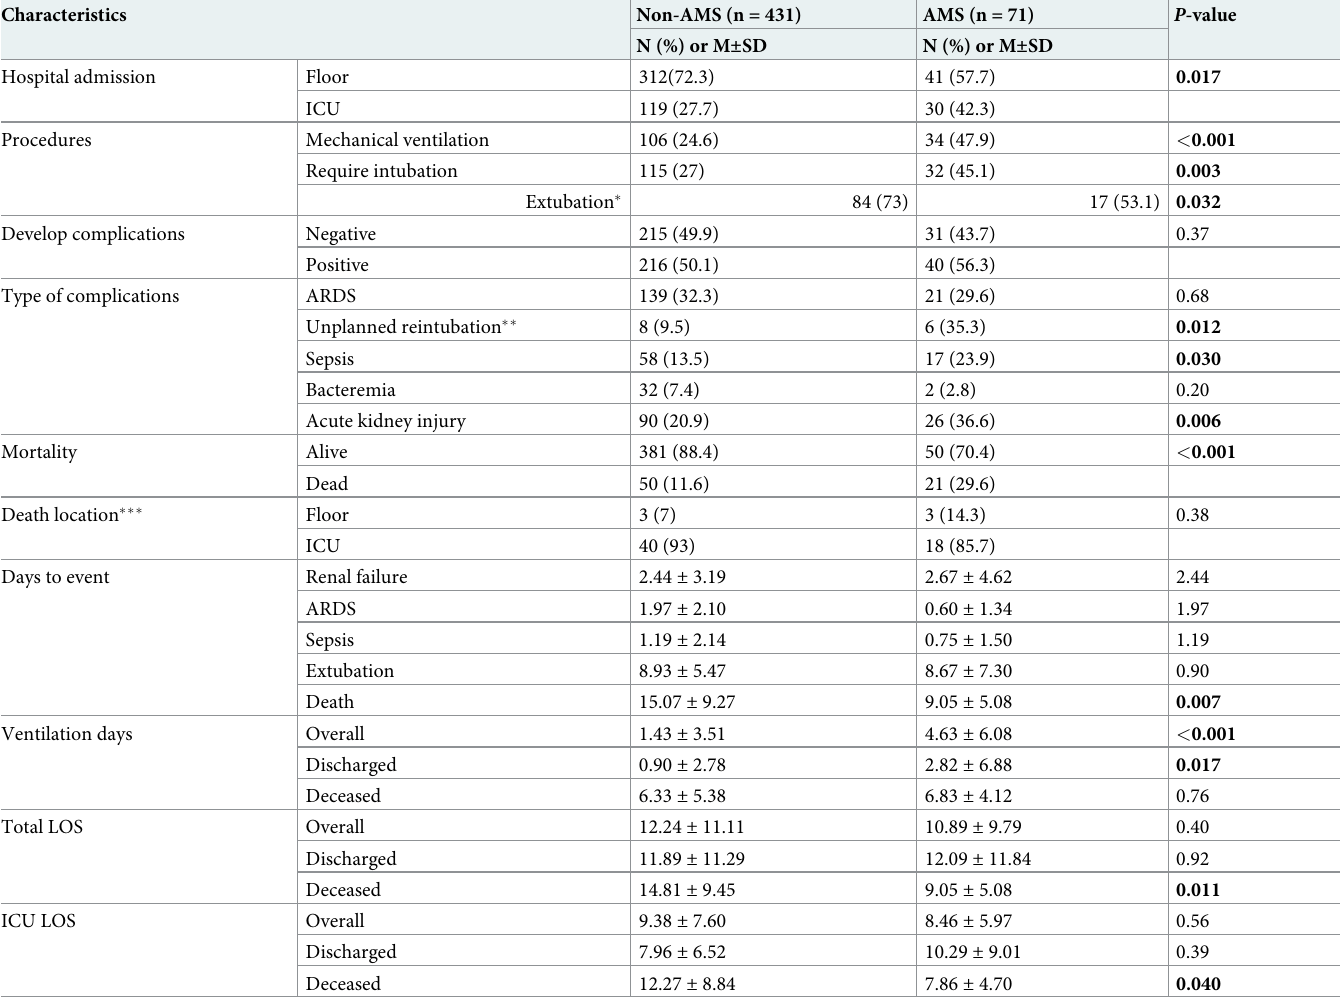
Data are presented as mean and standard deviation (M ± SD) or frequency and percentage between parentheses. � Percentage among intubated patients �� Percentage among extubated patients ��� data for the death location for 7 patients were